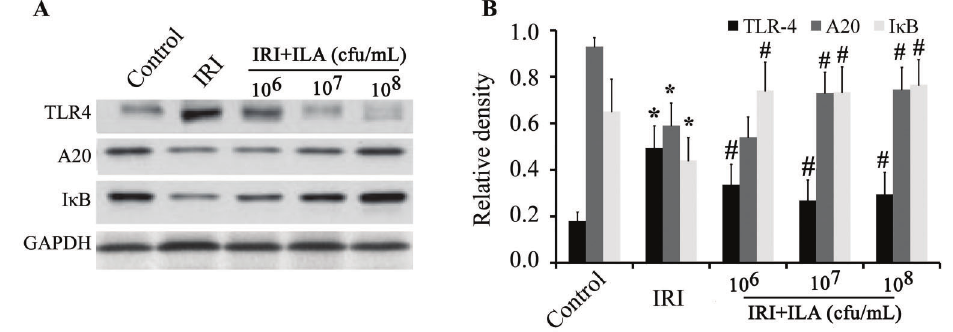
Figure 4. Effect of different concentrations of inactivated lactobacillus (ILA) after ischemia reperfusion injury (IRI) on the protein levels of TLR4, A20, and I- k B assayed by western blot analysis (n=4). Data are reported as means ± SD. *P o 0.05 vs control; # P o 0.05 vs IRI (ANOVA, followed by Duncan ’ s multiple range